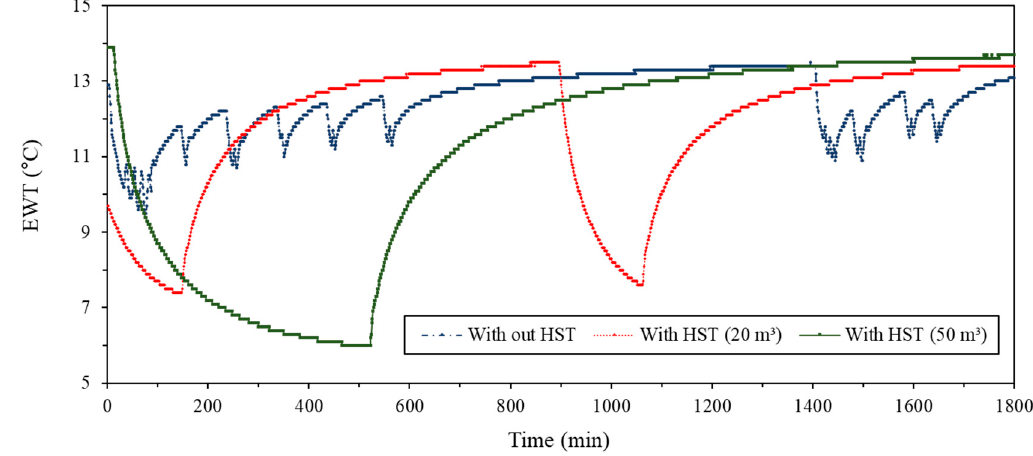
Figure 9. Entering water temperature (EWT) change according to the capacity of HST.